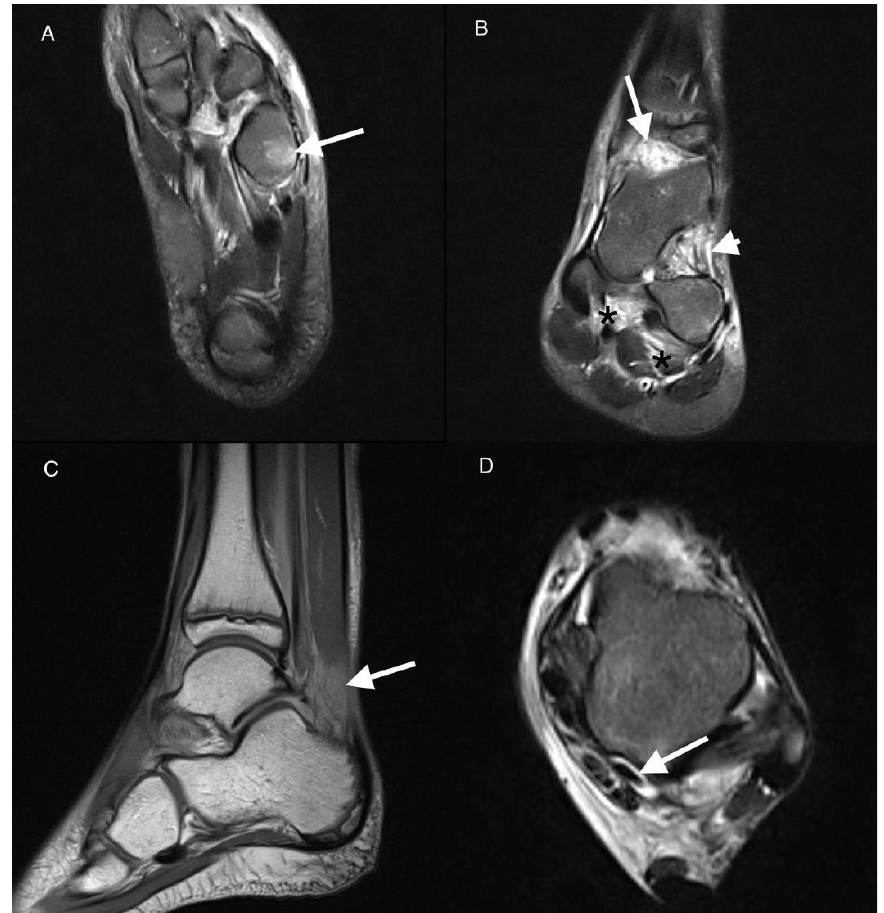
Figure 1. Magnetic resonance imaging (MRI) of the left ankle of an 11-year-old boy with juvenile idiopathic arthritis (JIA). T2-weighted turbo invertion recovery magnitude (TIRM) images in axial ( A , D ), coronal ( B ), and sagittal PD-weighted planes ( C ). Bone marrow edema (BME) stage 2 in the cuboid bone (arrow in ( A )). Effusion/synovial thickening stage 2 in the tibio-talar joint (arrow in ( B )). Fat tissue in sinus tarsi involvement stage 1 (arrowhead in ( B )). Enthesitis of the interosseous ligaments stage 1 (black asterisks in ( B )). Kager’s fat pad inflammation arrow in ( C ). Tenosynovitis of the flexor hallucis longus muscle tendon stage 1 arrow in ( D ).